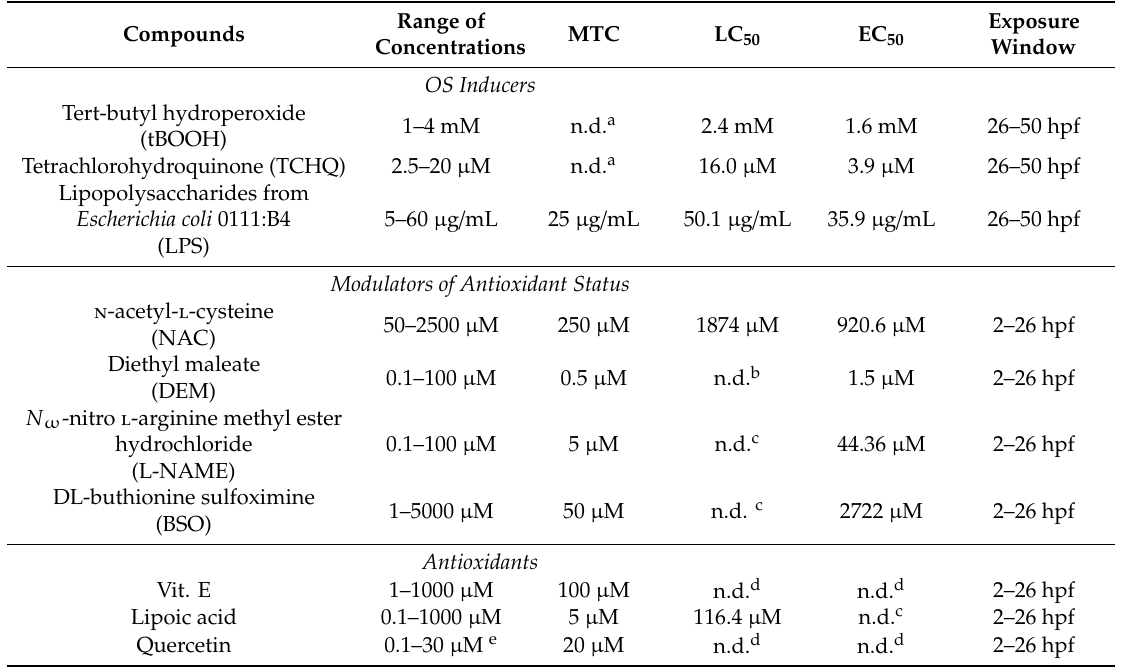
Table 1. Characterization of lethality and dysmorphogenesis in zebrafish embryos, produced by oxidative stress-related